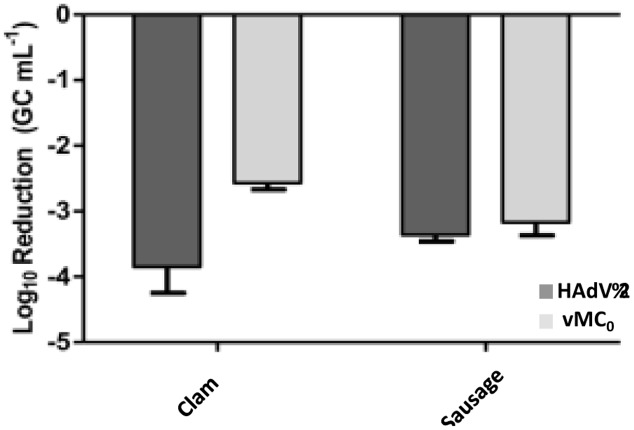
Mean virus inactivation observed in food samples treated with PMA. Dark and pale gray bars represent HAdV-2 and vMC0, respectively.